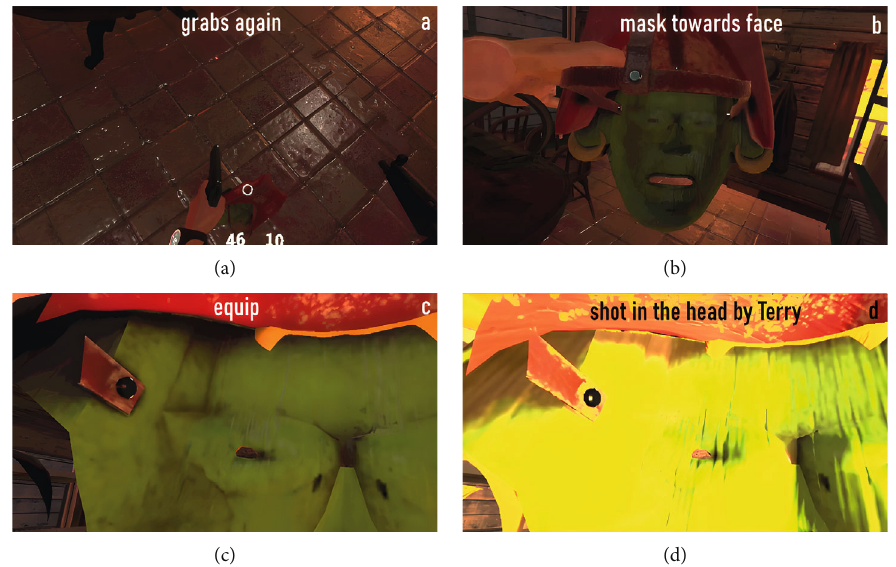
Figure 7: Sequence repeat. Attention-seeking fi rearm use.